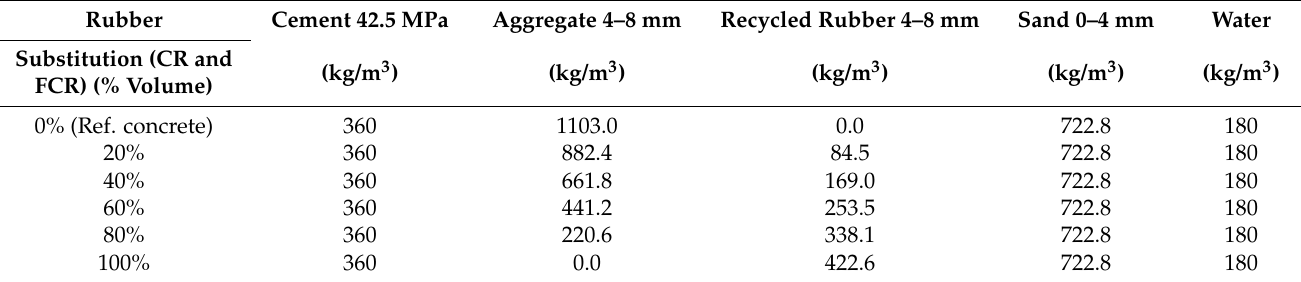
Table 5. Mix proportions of the different concrete mixtures [34]. Copyright© 2017, Elsevier B.V.